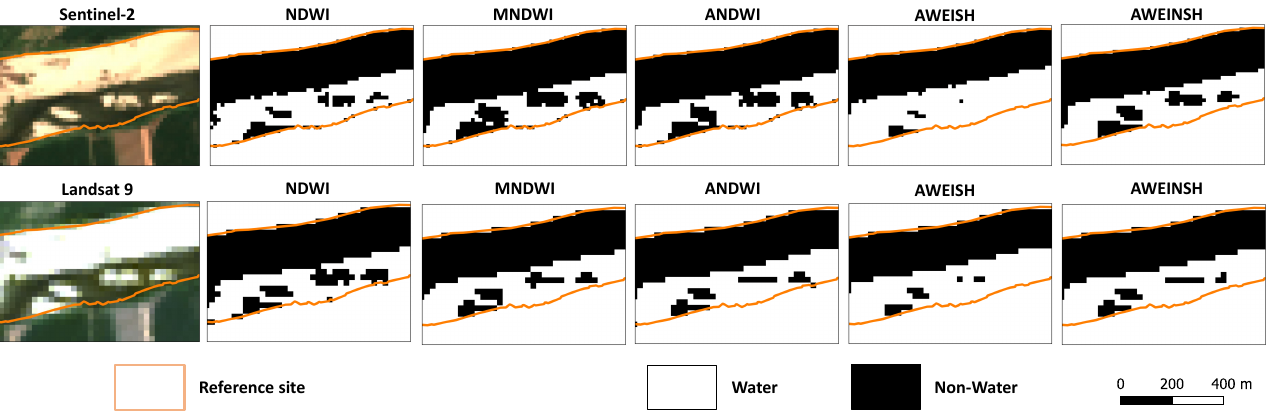
Figure 12. Detailed view of the river bed mapping in a section of the river that exhibits the presence of multiple sandbars. The two panels more to left show 20 m Sentinel-2 RGB image ( top row ) and 30 m Landsat 9 RGB image ( bottom row ). The other panels show the corresponding mapping that resulted from the analysis of the five water indices (NDWI, MMNDWI, ANDWI, AWEInsh, AWEIsh) using the same criteria applied in Figures 9 and